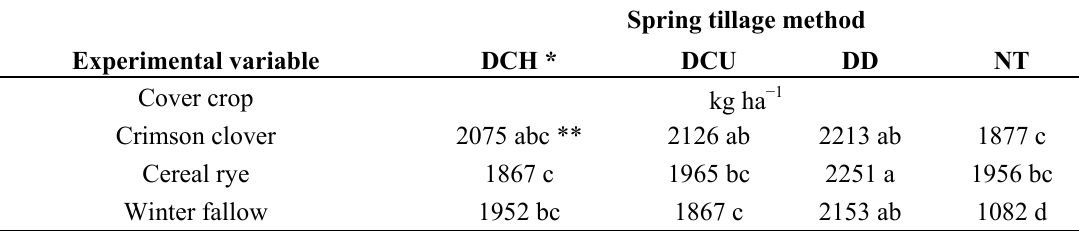
Table 6. Interaction effect of cover crop by spring tillage method on cotton yield; data combined over cover crop and production